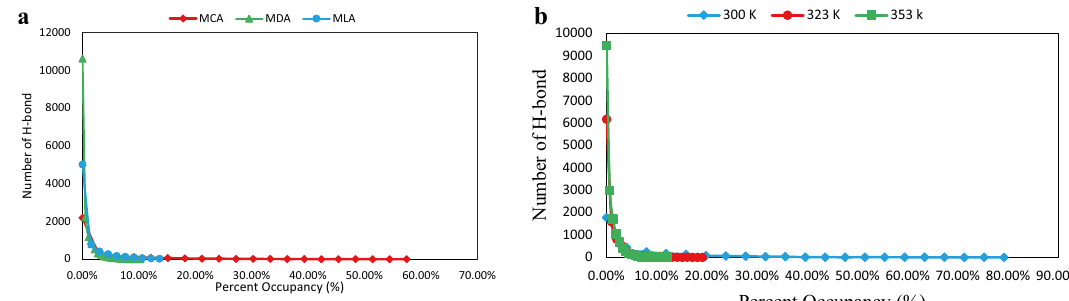
Figure 6. ( a ) Hydrogen bond percent occupancies between the H atoms of MEN and the O atom of FAs in the binary mixture with a molar percentage of 70% at 323 K, ( b ) Hydrogen bond percent occupancies between the H atoms of MEN and the OA atom of LUA in the binary mixture with a molar percentage of 25% at different temperatures.